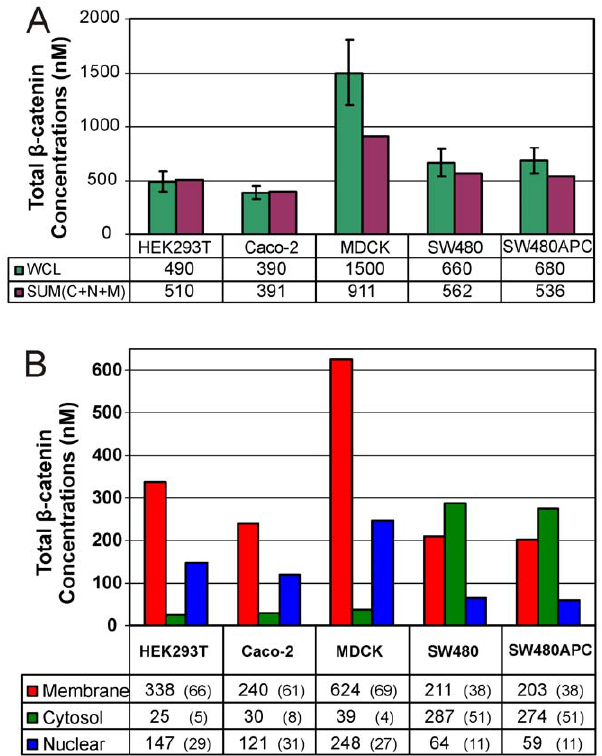
Figure 7. Sub-cellular distribution of b -catenin in mammalian cells. (A) Compartment concentrations for b -catenin in HEK293T, Caco- 2, MDCK, SW480 and SW480APC cells. Note: Percentage of whole cell b - catenin concentrations is in parentheses. (B) Protein recoveries (Sum of compartment proteins) from the fractionation experiment compared with the measured whole cell